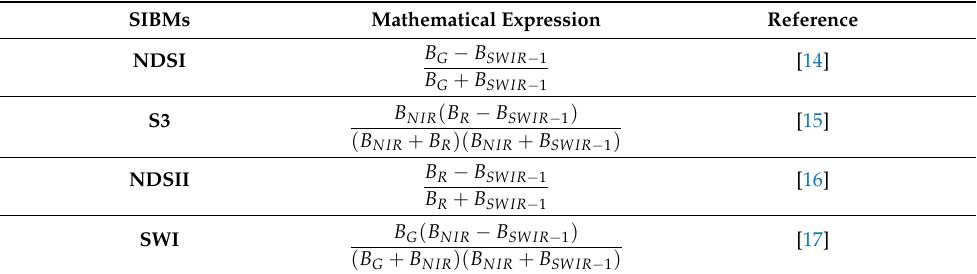
Table 3. Summary of the Snow Index-Based Methods (SIBMs) used in this research to compare the performance of the Non-Binary Snow Index for the Multi-Component Surfaces method.